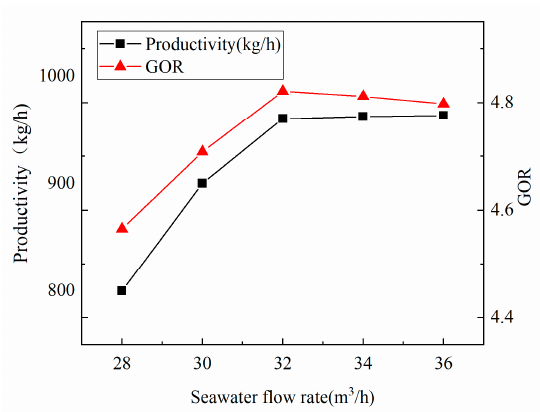
Figure 8. Effect of seawater flow rate on system productivity and GOR.